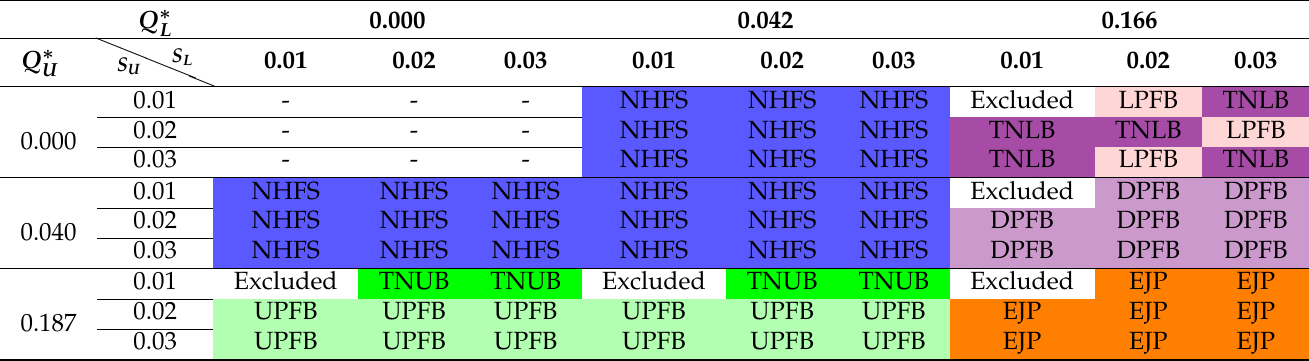
Table 2. Summary of the observed pressurization modes grouped by inflows versus slope